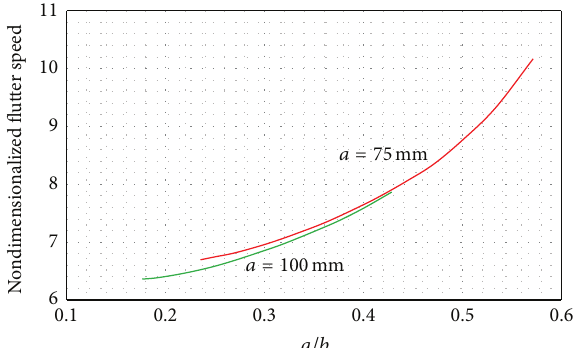
Figure 6: Nondimensionalized locked-in flutter